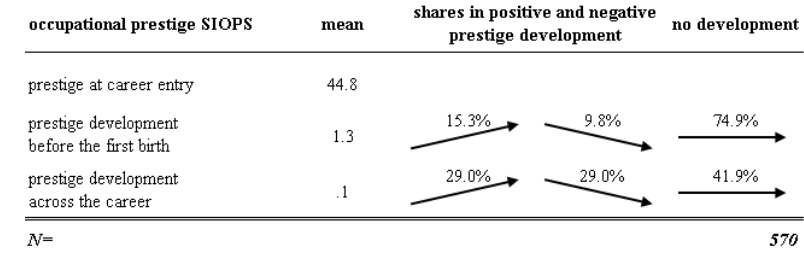
Table 3 : women’s occupational prestige and prestige development